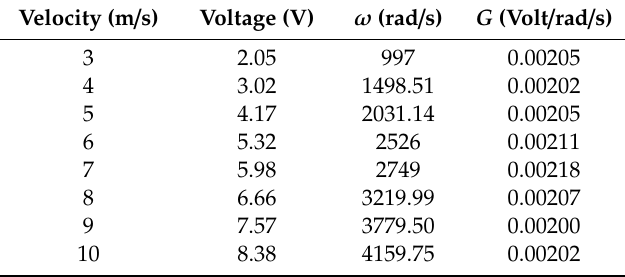
Table 5. Numerical values of the electro-mechanical coe ffi cient for di ff erent air